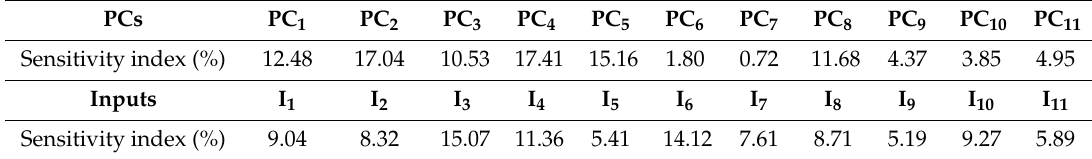
Table 5. Sensitivity index of Principal Components (PCs) and Inputs, respectively.